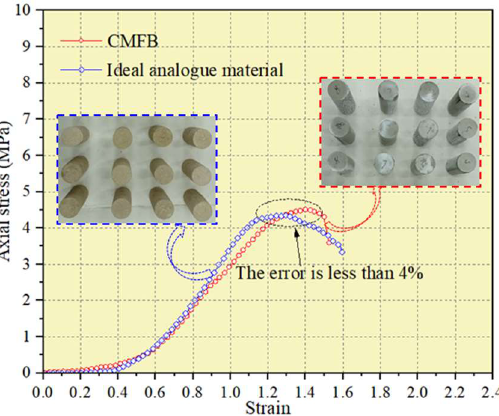
Figure 7. The stress–strain curves of the CMFB and its similar materials in analogue simulation.